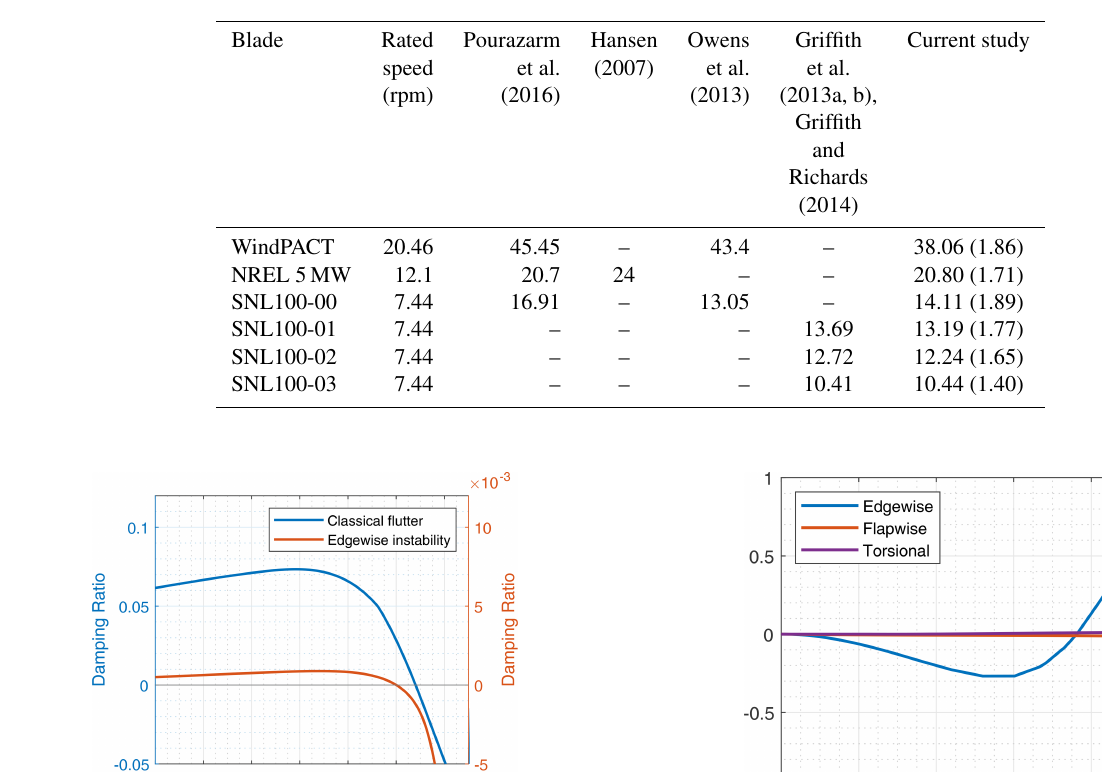
Table 3. The flutter speeds in revolutions per minute: current study and previous studies for a few blade models.